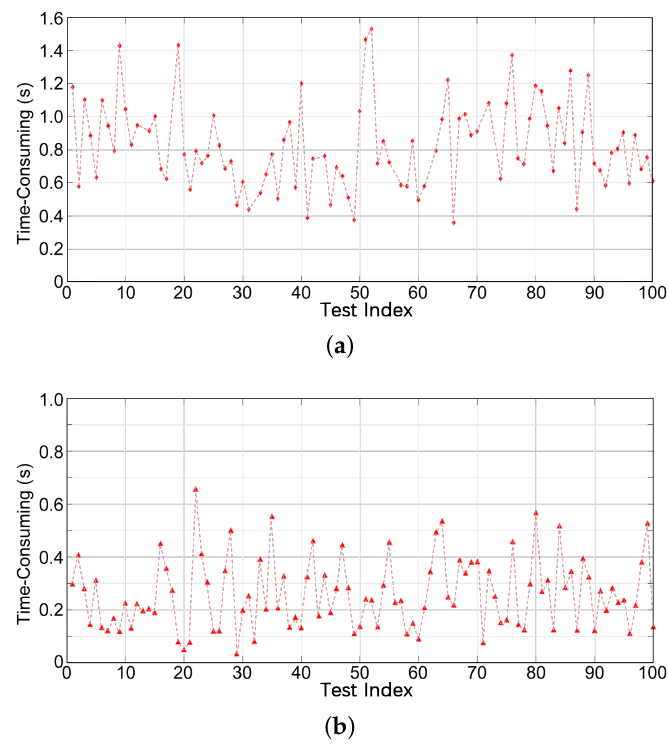
Figure 13. Computation time evaluation of the match process on ( a ) KITTI sequence 00 and ( b ) our campus dataset.